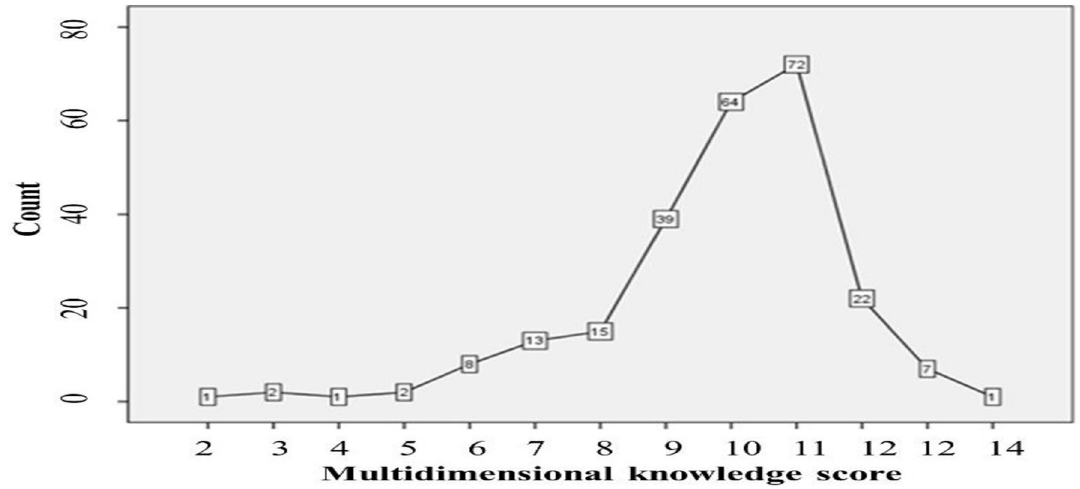
Fig 2. Line graph showing counts for summation scores of knowledge items about COVID-19, Jimma-Ethiopia, March, 2020.